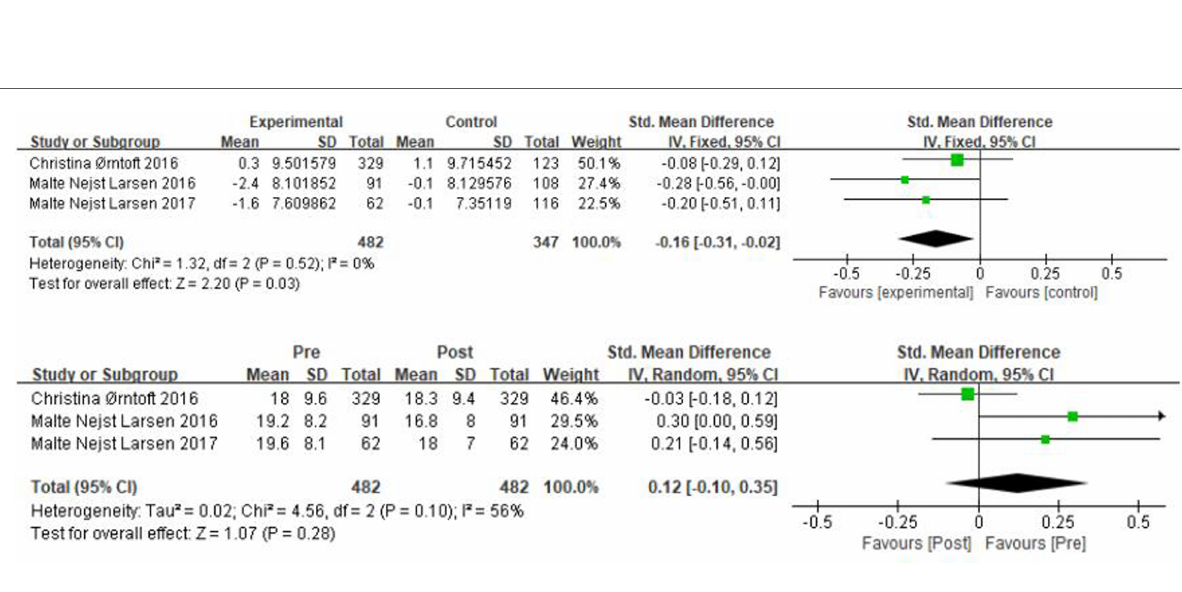
FIGURE 9 A meta-analysis of the results of fl amingo balance was conducted for comparisons between the control and experimental groups and for comparisons between the experimental groups pre- and